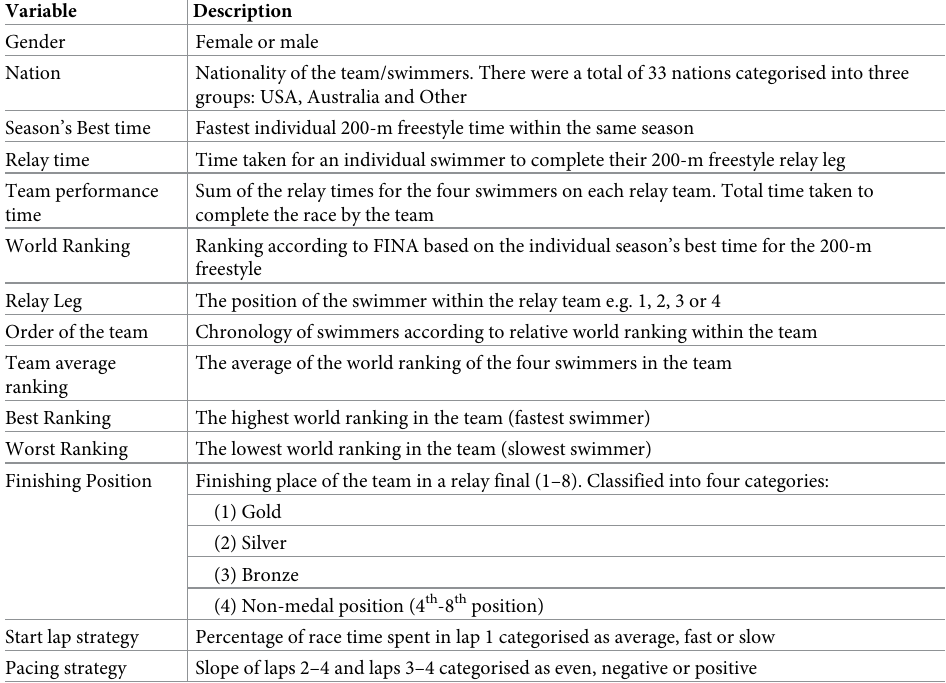
Table 1. Description of the explanatory